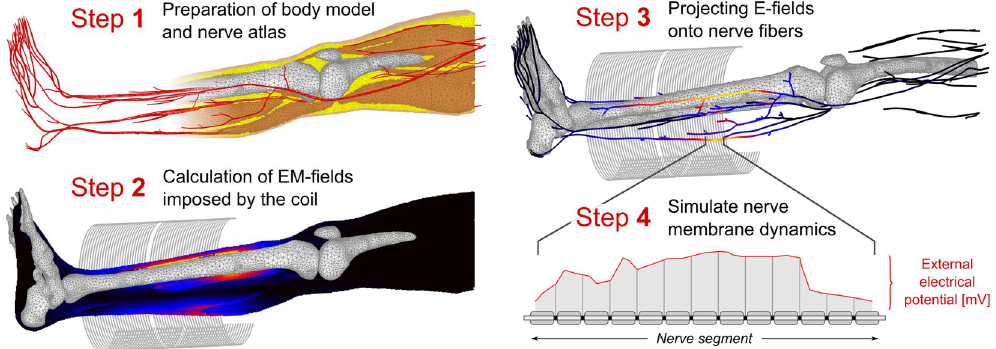
Figure 1. Flowchart of the PNS simulation process. Step 1: Preparation of the body model and nerve atlas (only required once). Step 2: EM fields imposed by the coil are calculated. Step 3: The electric field for a given coil current waveform is interpolated and projected onto the nerve fiber. Step 4: Nerves response is calculated to determine if an AP has been initiated. If no AP is reached, steps 3 and 4 are repeated with a higher amplitude coil current waveform until PNS is observed.